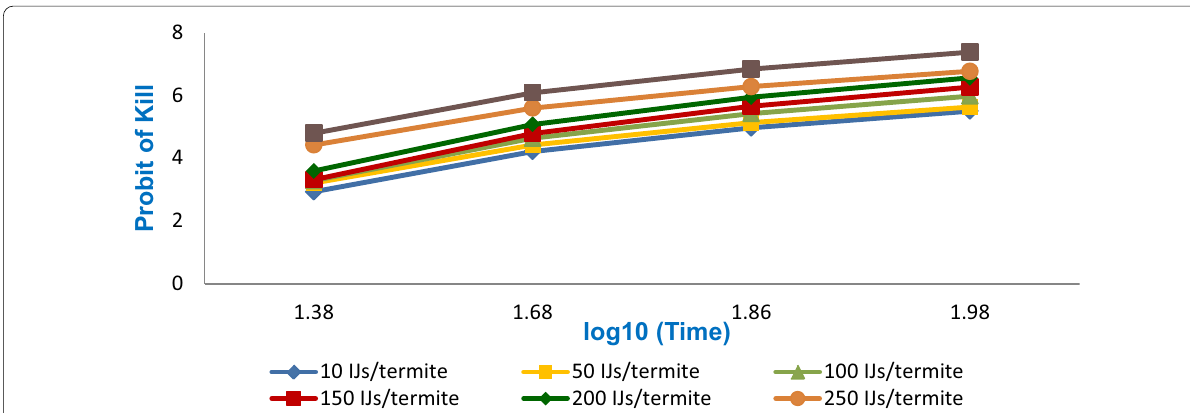
Fig. 1 Time response curve of O. obesus workers exposed to H. bacteriophora during different time intervals and concentrations